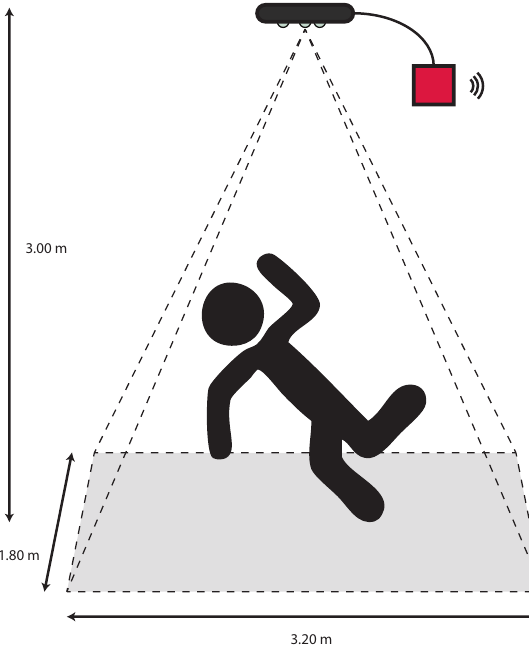
Figure 15. Representation of the RGB-D camera